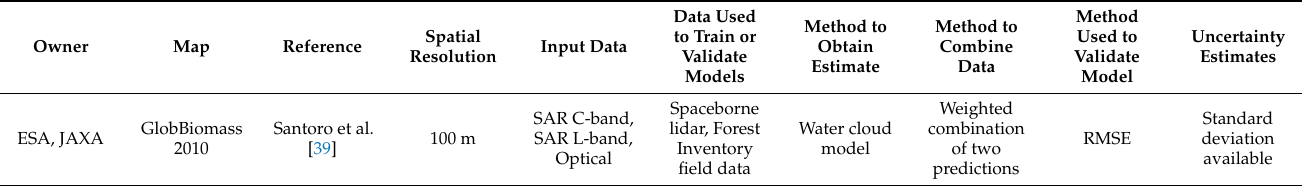
Table 2. Data and methodology used to produce global AGB